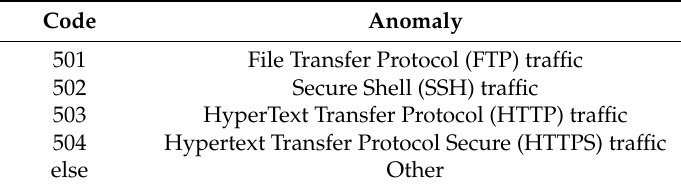
Table 2. Anomalies with a code value between 500 and